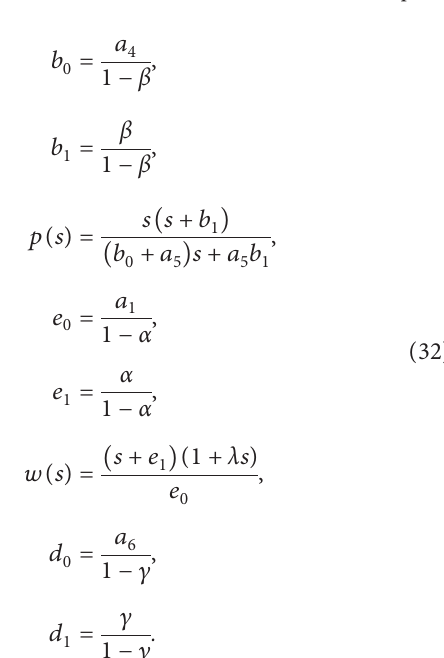
Figure 5: Variation of temperature (a) and velocity (b) of